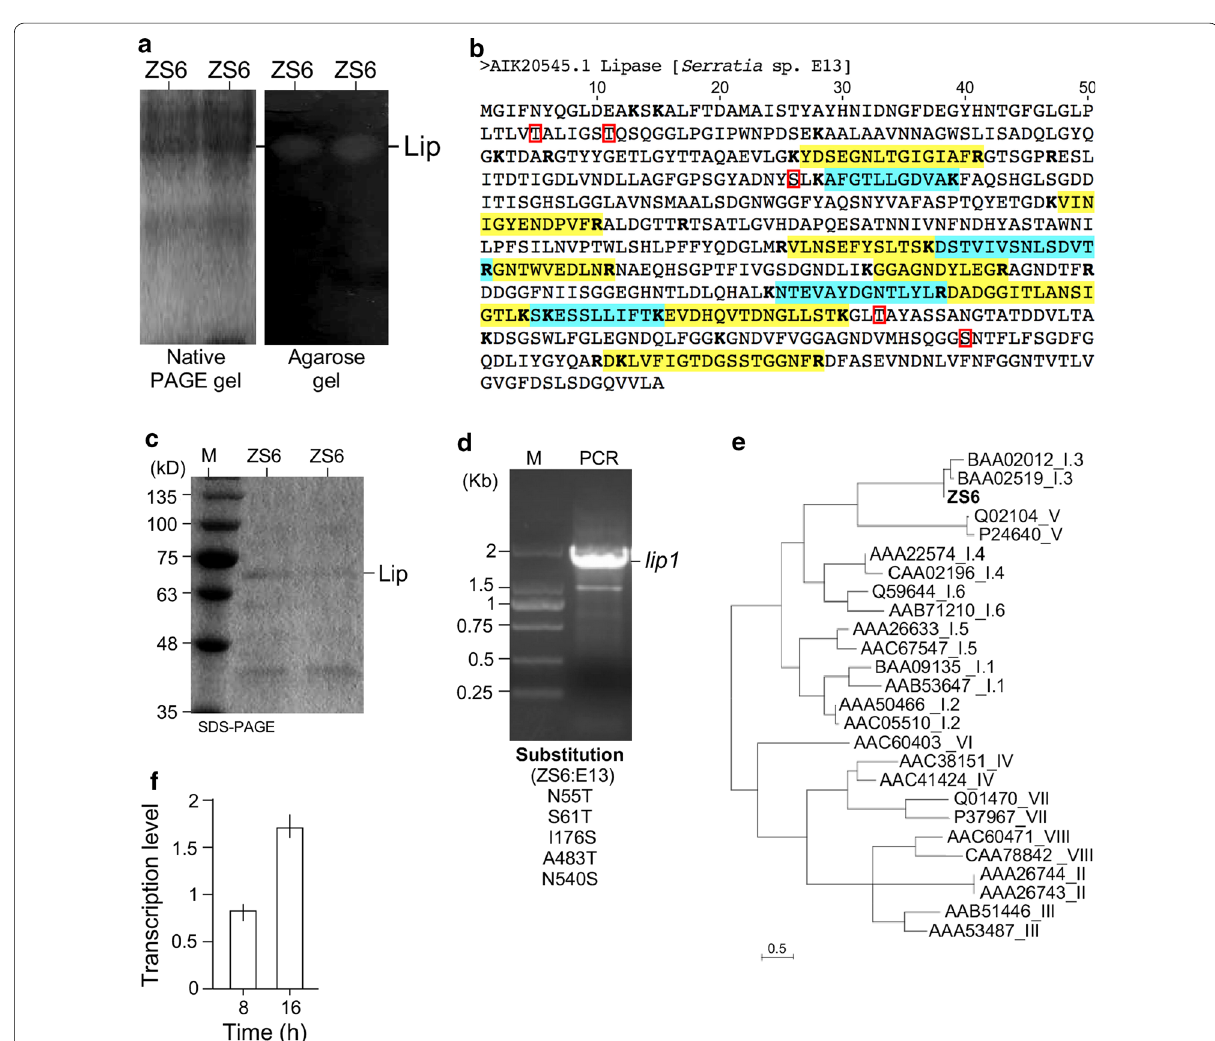
Fig. 4 Identification of lipase protein and gene sequences in ZS6. a In-gel lipase assay. Left panel shows the native PAGE analysis of proteins prepared from supernatant of ZS6 culture. The right panel shows the in-gel analysis of lipases. Bright spots indicate the increase of acidity caused by lipid hydrolysis. b Lipase shared with trypsinized peptide sequences generated in LC–MS/MS analysis. Residue at the end of trypsin peptides were highlighted in bold. Peptide sequences identified by MS analysis are highlighted. Residue at the end of trypsin peptides were highlighted in bold. c Probable lipase protein in SDS-PAGE gel. d Probable lipase encoding DNA is amplified using PCR analysis. Amino acid substitutes between E13 Lip and ZS6 Lip are shown in the bottom panel. Five amino acid substitutions were found in the deduced protein sequences compared with that of the E13 LipA. e Sequence-based lipase phylogenetic tree analysis. Sequences whose Genbank accession number (ZS6, MG897498.1) followed by the lipase family [I–VIII families (Arpigny and Jaeger 1999)] is shown. g Levels of lipase gene expression at 8 h and 16 h after growth based on RT-qPCR analysis are